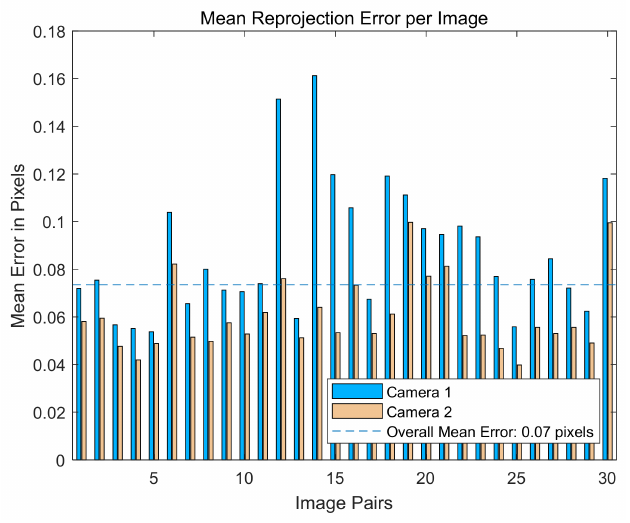
Figure 10. Reprojection error distribution of 30 calibration